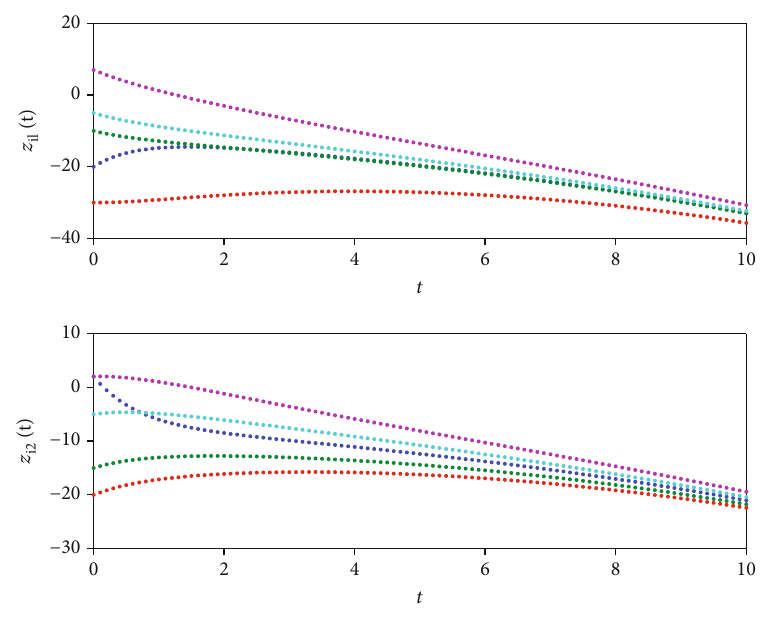
Figure 3: Error z